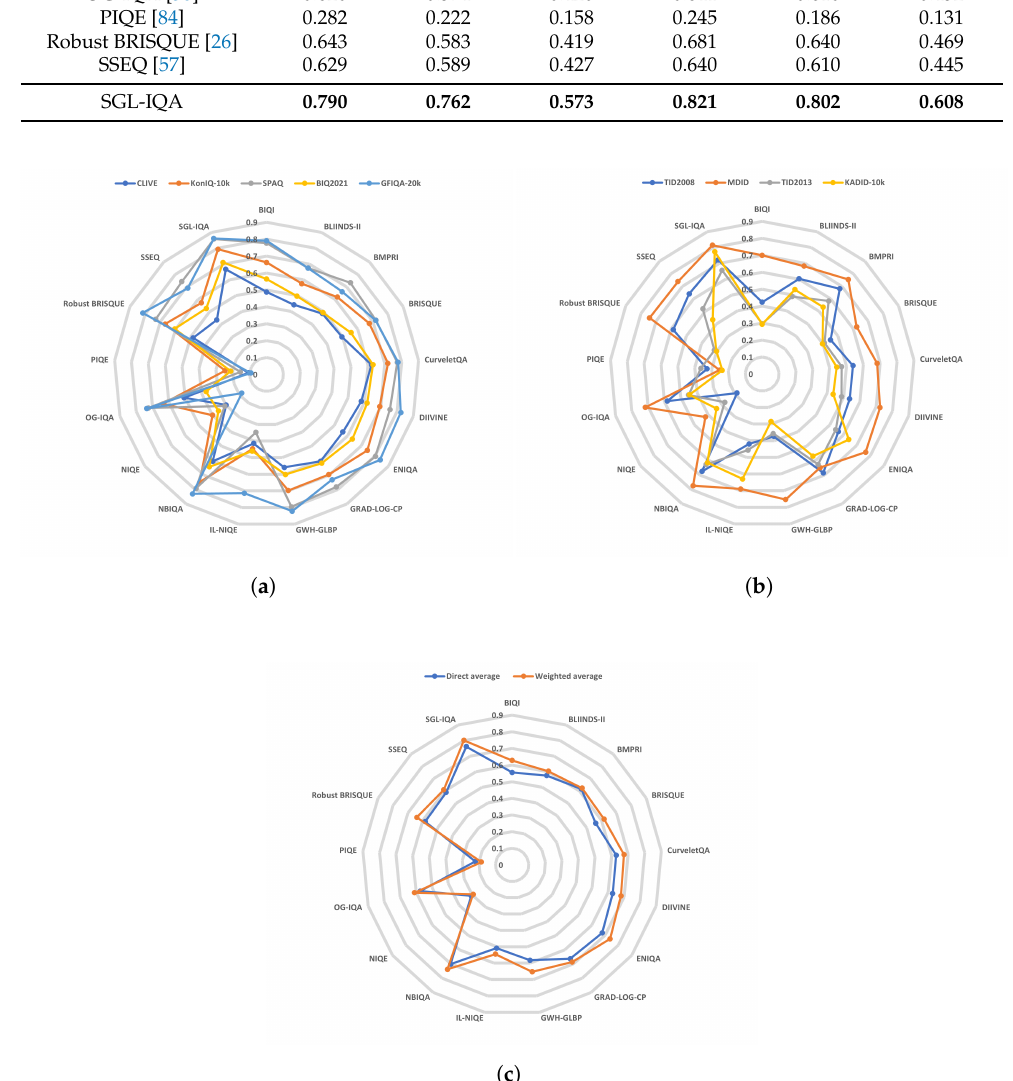
Figure 7. Radar graphs for SROCC comparison to other advanced NR-IQA methods based on ( a ) authentic distortions, ( b ) artificial distortions, and ( c ) overall performance on the considered benchmark